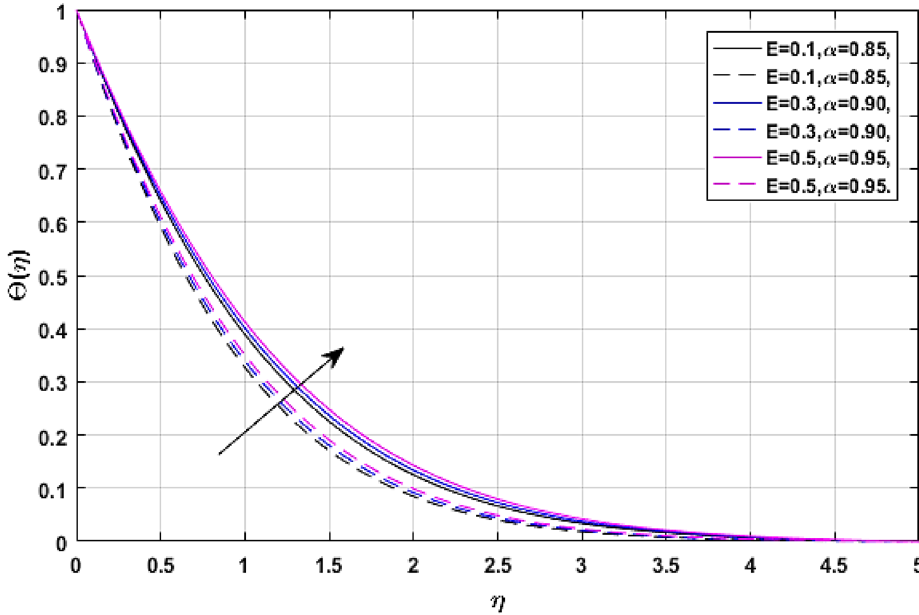
Figure 14. E versus temperature field when (cid:31) = M = Ec = 0.1, φ 1 = φ 2 = 0.02, Pr = 21.